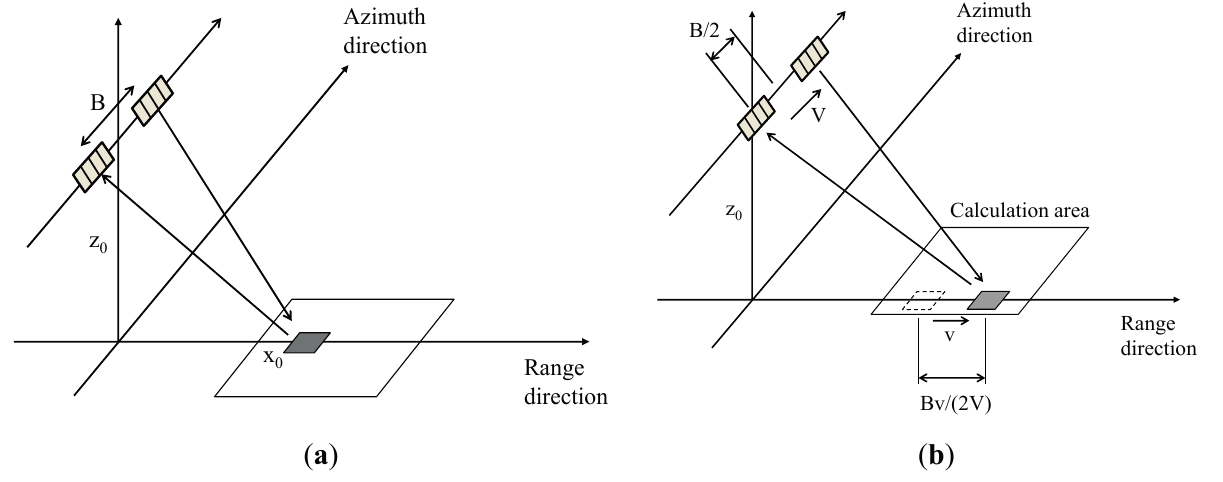
Figure 3. Relationships between AT-InSAR and a moving target. ( a ) Before target movement; ( b ) After target